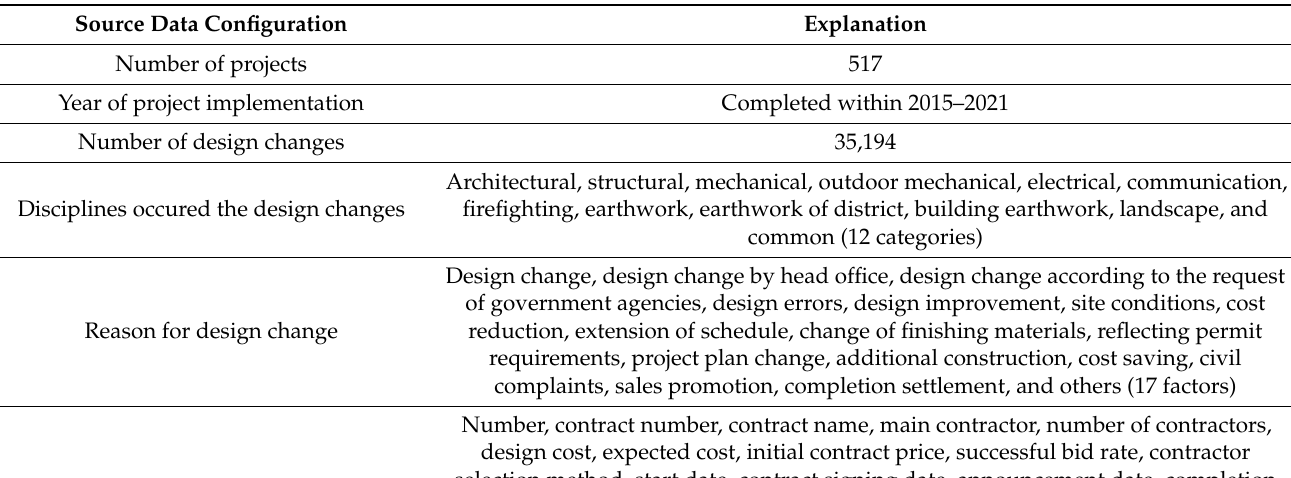
Table 1. Composition of original case